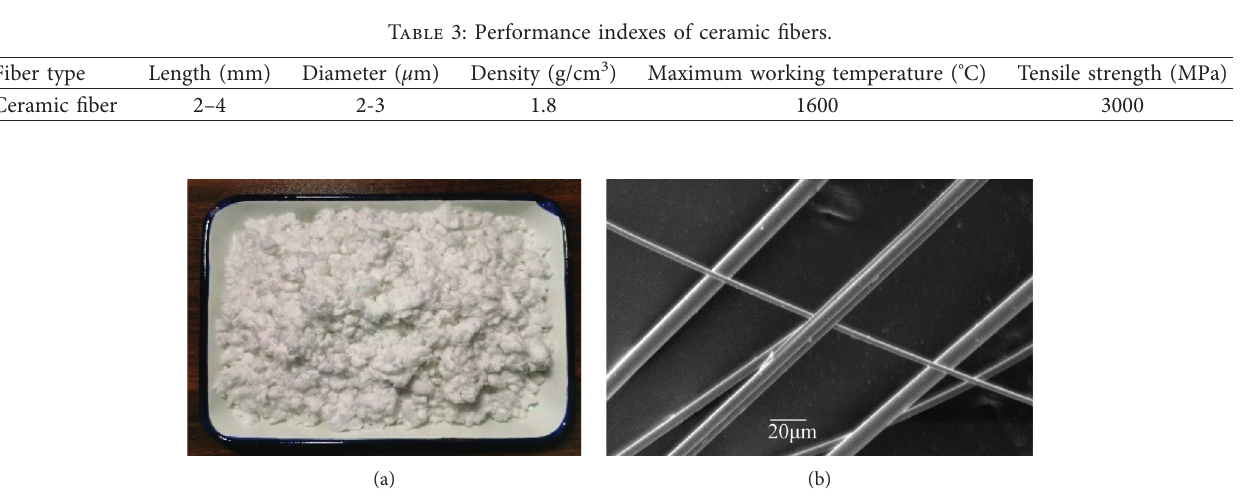
Figure 1: Appearance and micrograph of ceramic